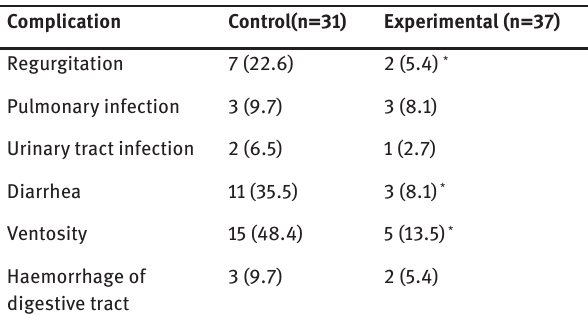
Table 4: Comparison of complications within the two groups during the treatment [n (%)].